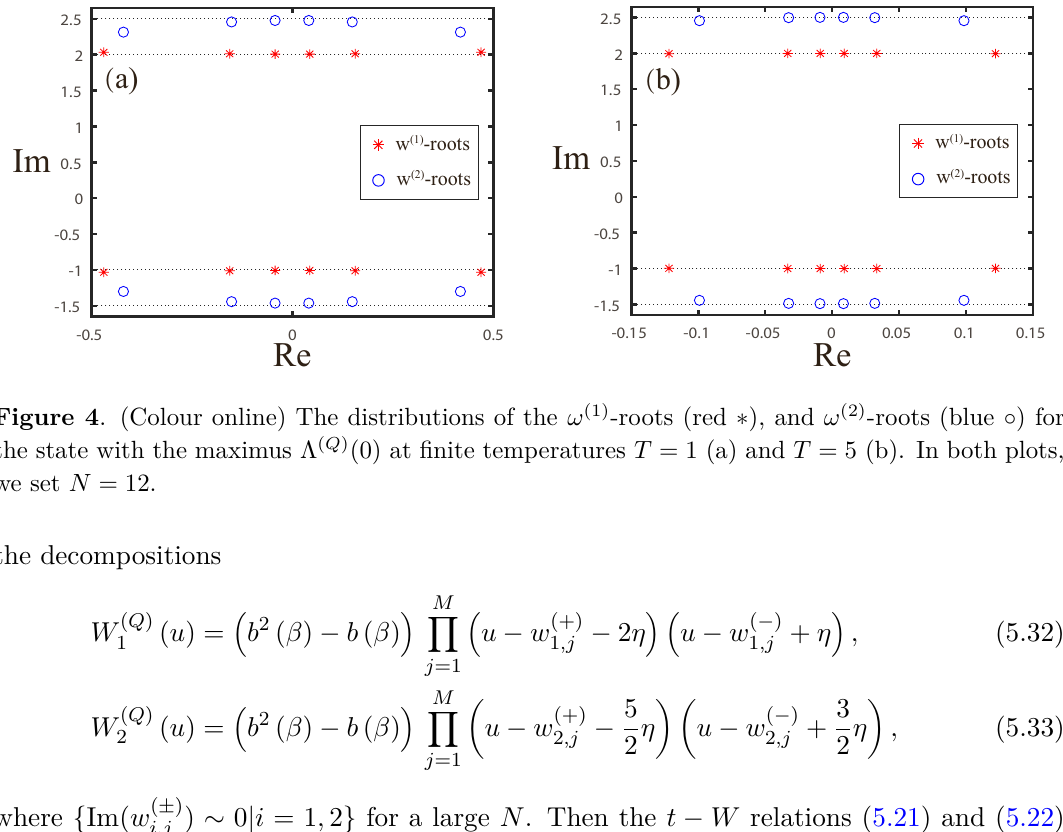
Figure 3 . (Colour online) The distributions of the λ (1) -roots (red ∗ ), λ (2) -roots (blue ◦ ), z (1) -roots (mauve (cid:3) ) and z (2) -roots (black M ) for the state with the maximus Λ ( Q ) (0) at finite temperatures T = 1 (a) and T = 5 (b). In both plots, we set N = 12 .